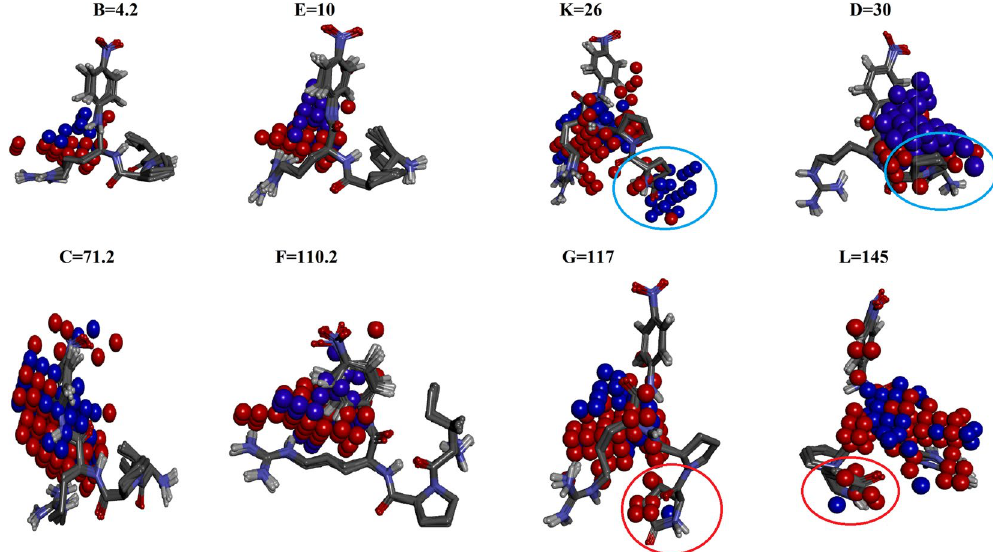
Figure 7. IEDs with positive and negative rc derived from the best QSAR model mapped on the substrates. Clear differences are seen in the arrangement of IEDs, precisely correlating with the enzymes showing high and low activity. The blue and red spheres represent IEDs with positive and negative rc respectively, within 2.5 Å radius to the substrate conformations. The alphabets represent the codes and the respective substrate conformations in the CEPs of a specific enzyme variant. The number represents the K cat values. The regions encircled in blue and red over pyroGlu moiety are IEDs that differentiated enzymes with low and high activity